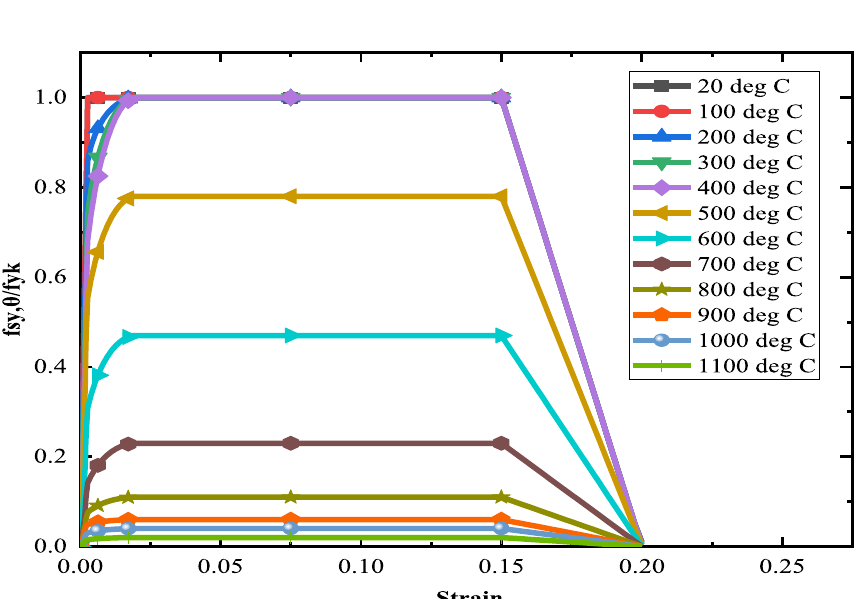
Fig. 23 Stress-strain of steel at elevated temperature